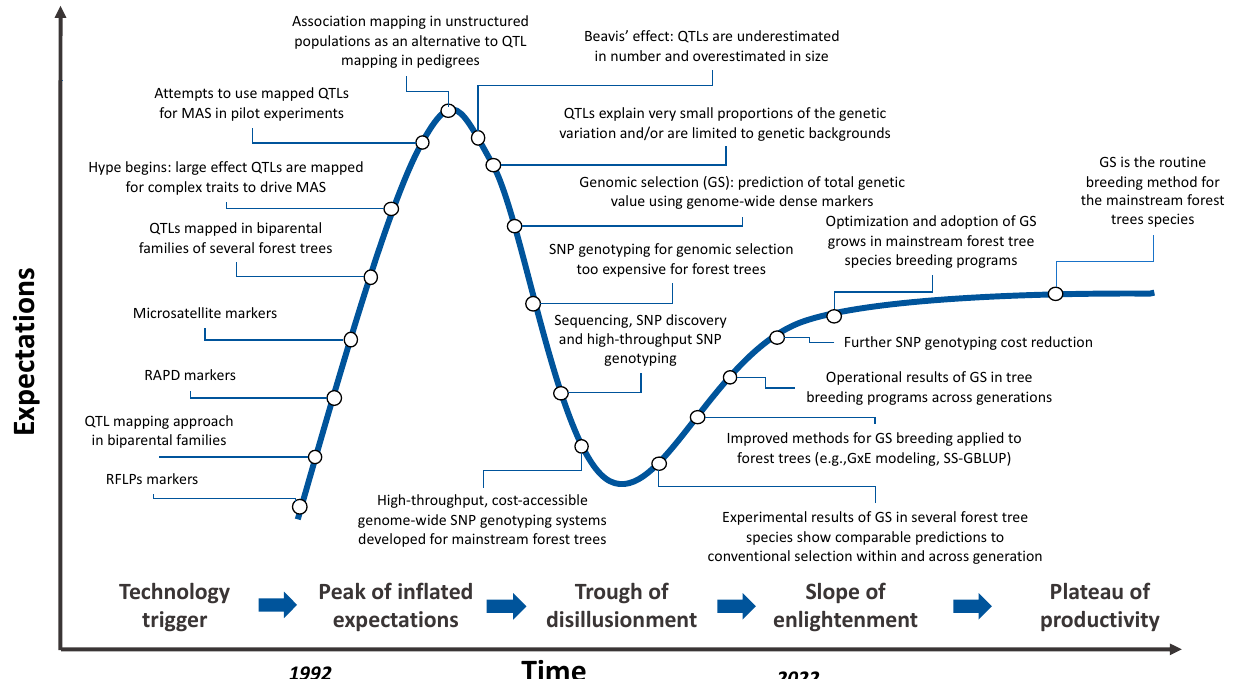
Figure 1. The timeline of marker assisted breeding in forest trees closely tracked the Gartner hype cycle through its different phases along the last 30 years. To accommodate the timeline with the hype cycle, the sequence of events not always reflects their exact relative chronology along the curves or fit the specific phase of the cycle.